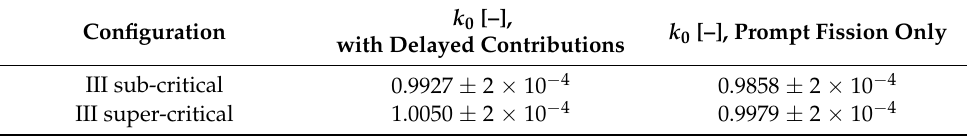
Table 6. Fundamental eigenvalues k 0 for Problem III.